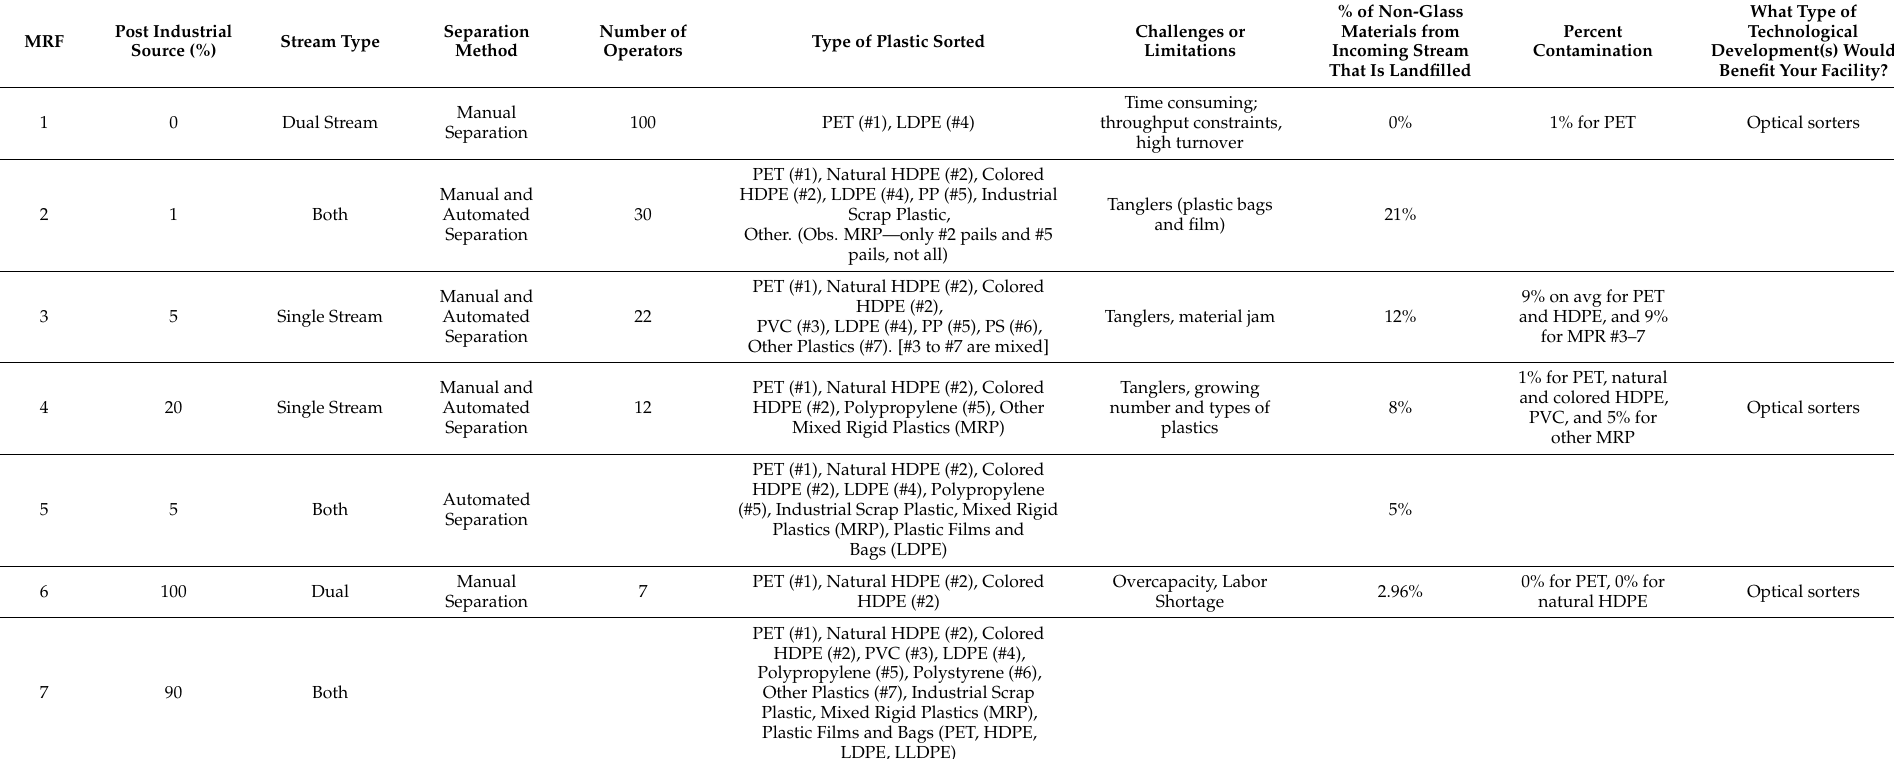
Table 2. Sorting efficiency based on collection method, stream type, and materials